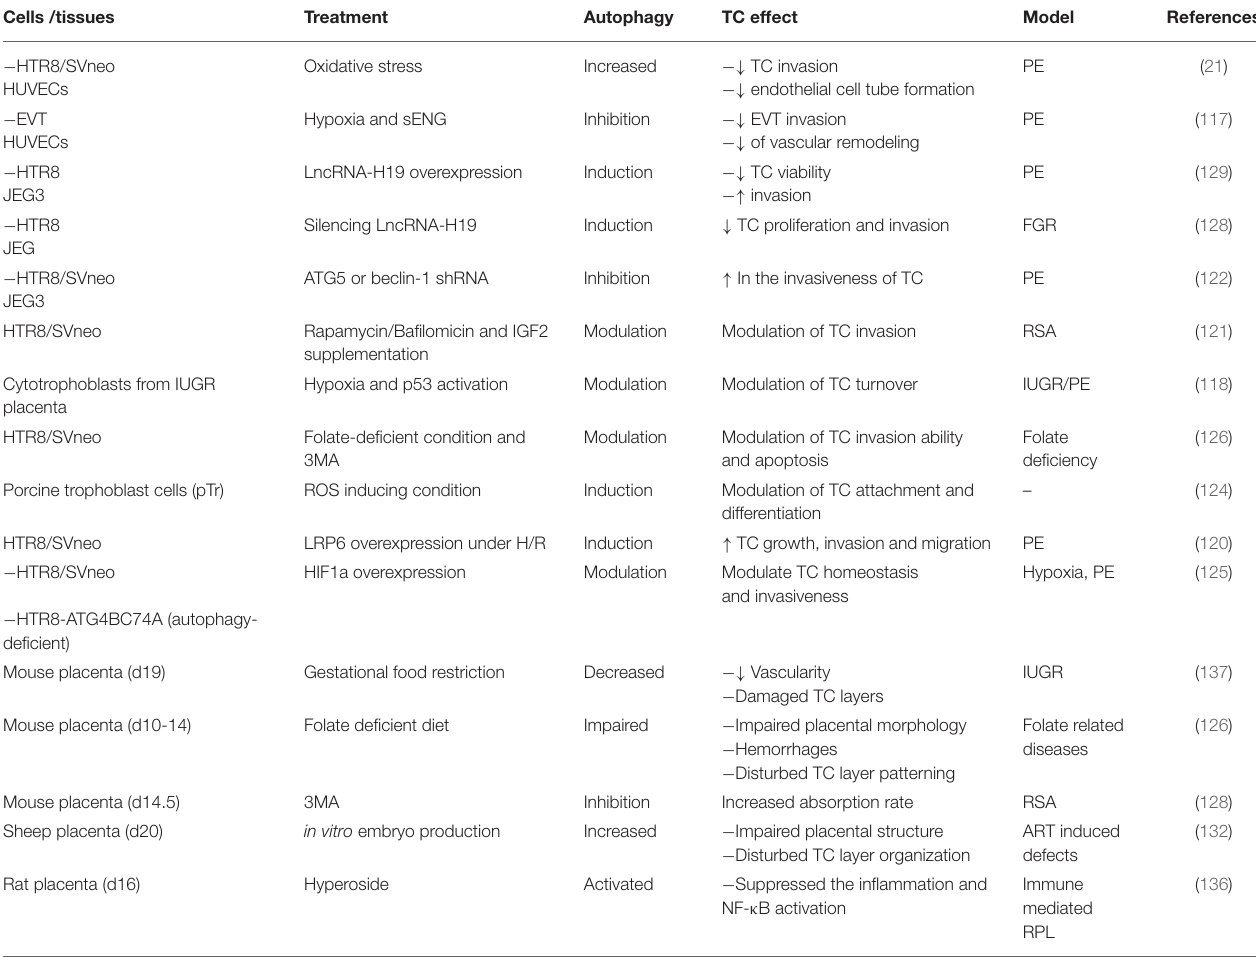
TABLE 1 | References on the role of autophagy on trophoblastic cell function and placental formation. Cells